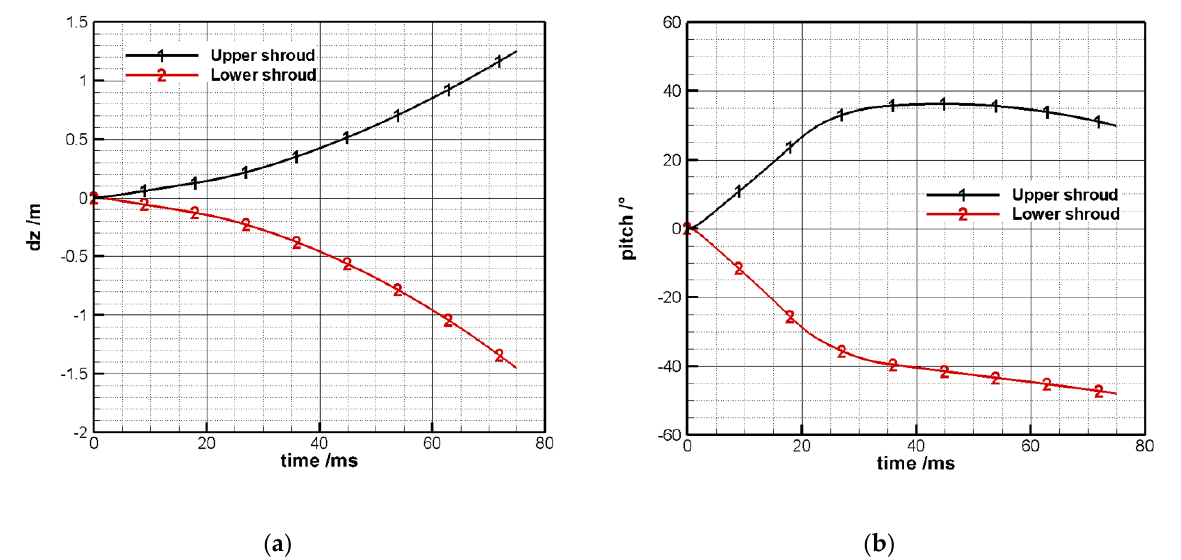
Figure 16. The trajectory of the shroud during the separation process: ( a ) z-direction distance; ( b ) pitch angle.